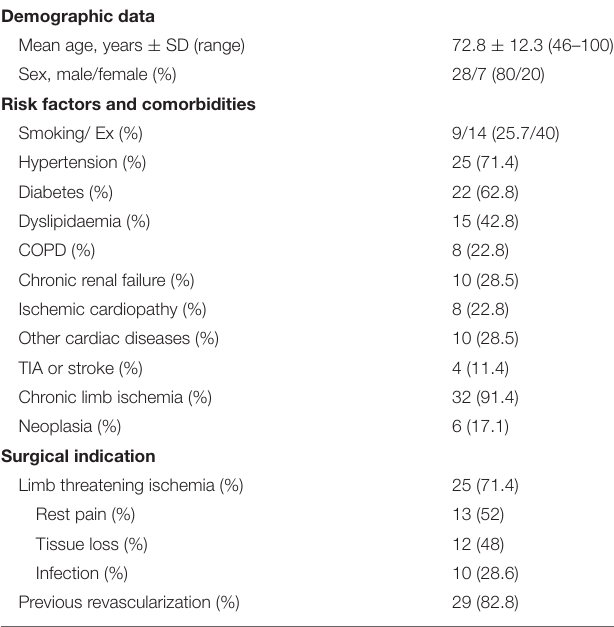
TABLE 1 | Patient characteristics.